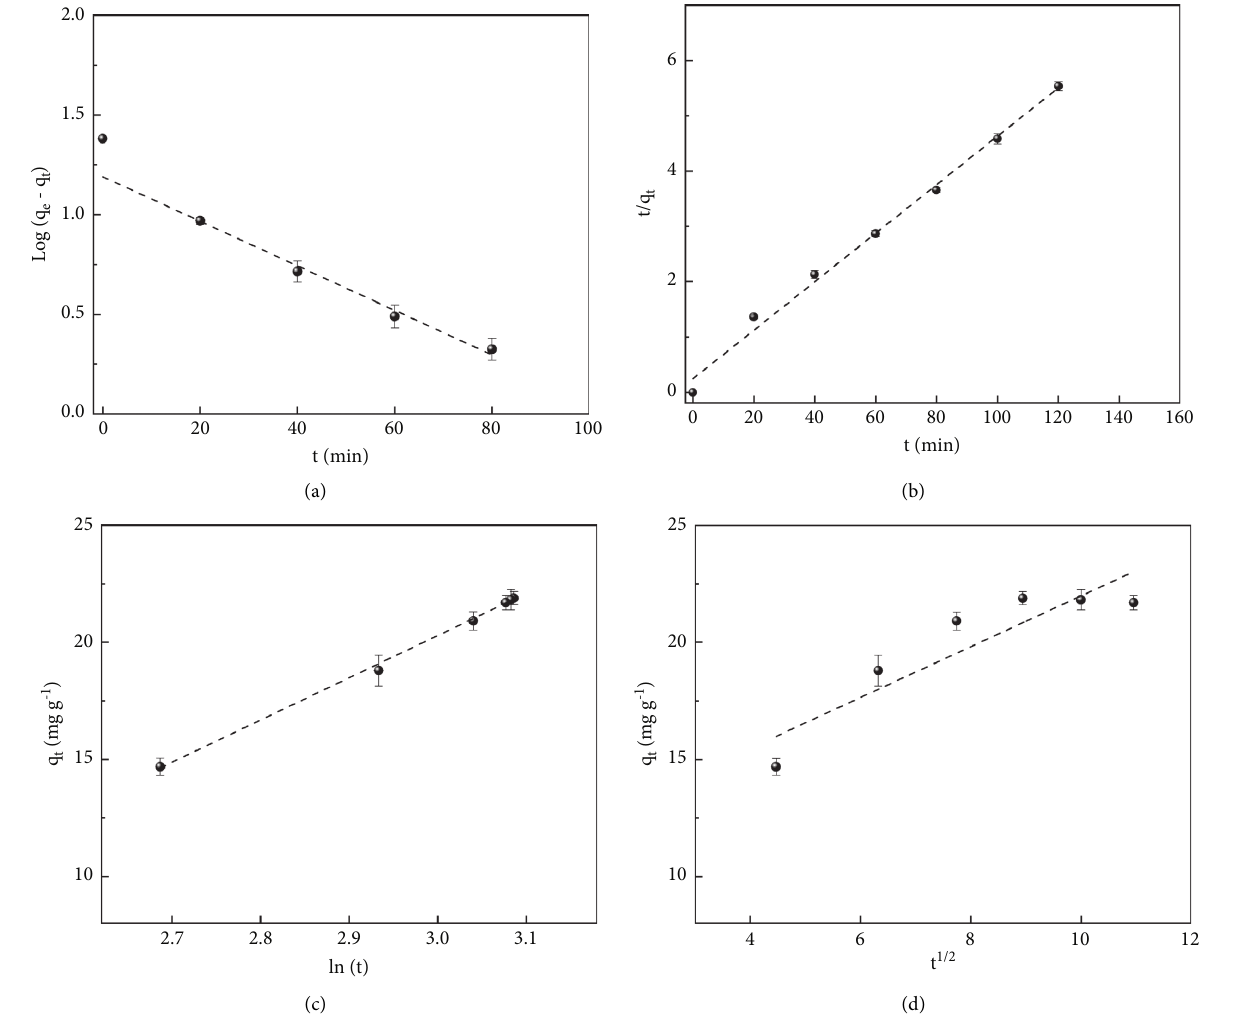
Figure 10: Pseudo-first-order model (a), pseudo-second-order model (b), Elovich kinetics model (c), and intraparticle diffusion kinetics model (d) for the adsorption of Zn 2+ ion by the AC/Fe 3 O 4 composite. Table 1: Kinetics model parameters for the adsorption of Zn 2+ ion by the ACP/Fe